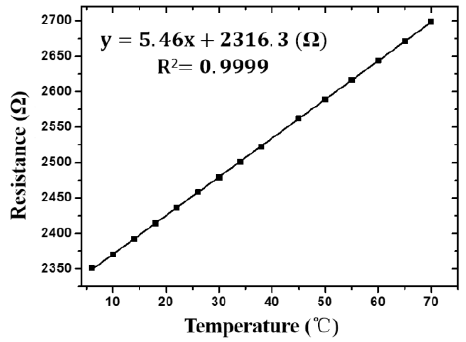
Figure 8. The linear relationship between resistance of RTD and temperature.